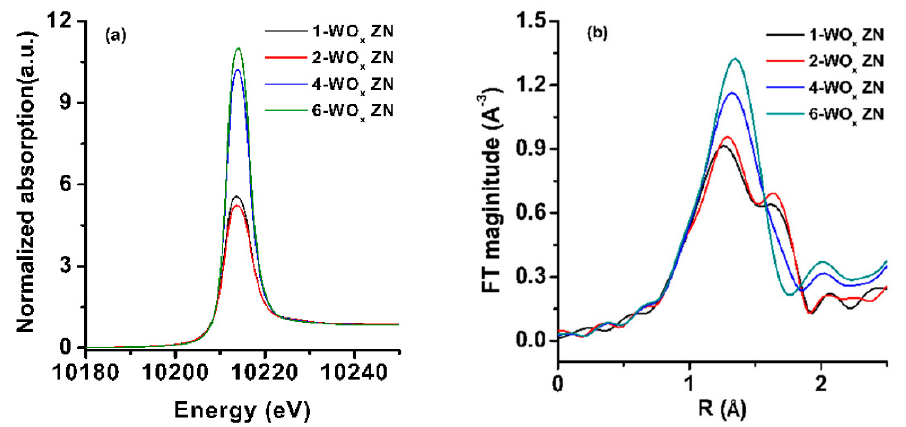
Figure 9. XANES ( a ) and EXAFS ( b ) spectra of the WO x supported on MFI nanosheet catalysts with various WO x loading contents. Reprinted with permission from [54] .